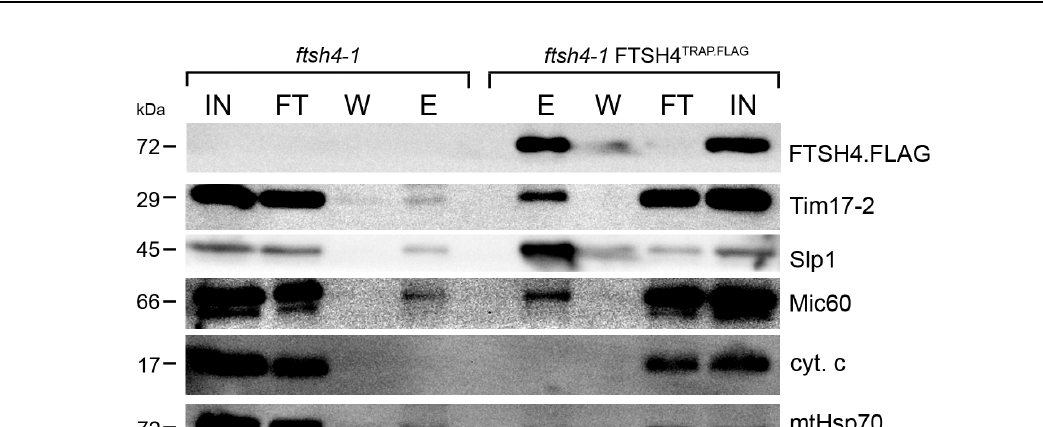
Figure 1. FTSH4 substrate trapping assay ( A ) Overview of FTSH4 substrate-trapping assay. Cartoon illustrating the experimental workflow; ( B ) Eluted fractions resolved on SDS-PAGE and stained with CBB. IMS—intermembrane space.